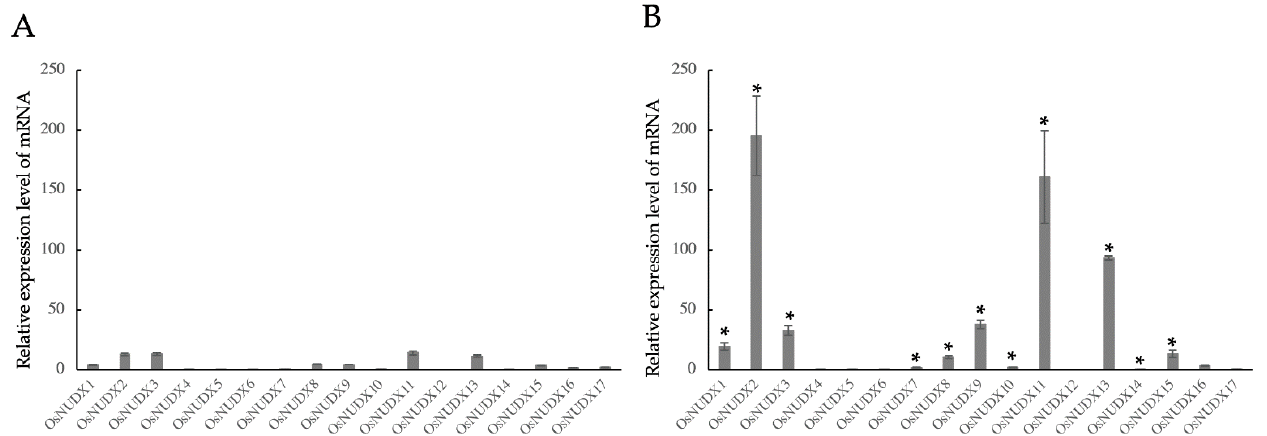
Figure 2. Expression profiles of the OsNUDX genes under UV-C irradiation. Total RNAs isolated from rice leaves ( A ) before and ( B ) after UV-C irradiation were subjected to quantitative RT-PCR. The expression levels were normalized with that of the glyceraldehyde 3-phosphate dehydrogenase gene as an internal control. The values denote the means ± SD ( n = 3). * p < 0.01.